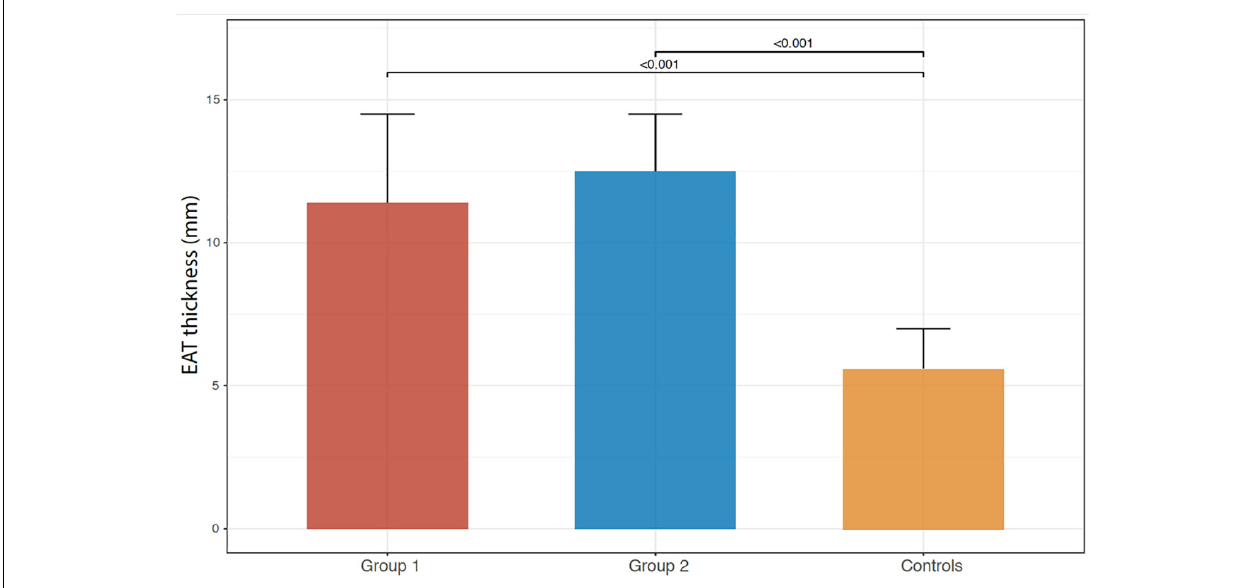
FIGURE 1 | Bar graphs illustrating EAT thickness in Groups 1 and 2 and controls.